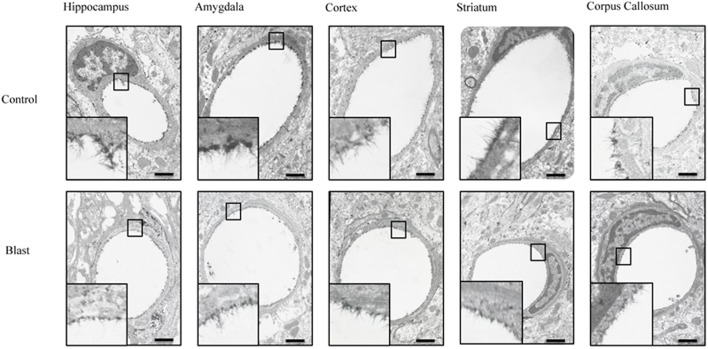
Blast exposure reduced glycocalyx thickness in brain capillaries. Representative electron micrographs of capillaries from hippocampus, amygdala, cerebral cortex, corpus striatum, and corpus callosum taken from blast and sham blasted animals. Endothelial glycocalyx is the darkly stained filamentous layer present on the lumen of the capillary. All insets represent magnified image; scale bar = 500 nm.